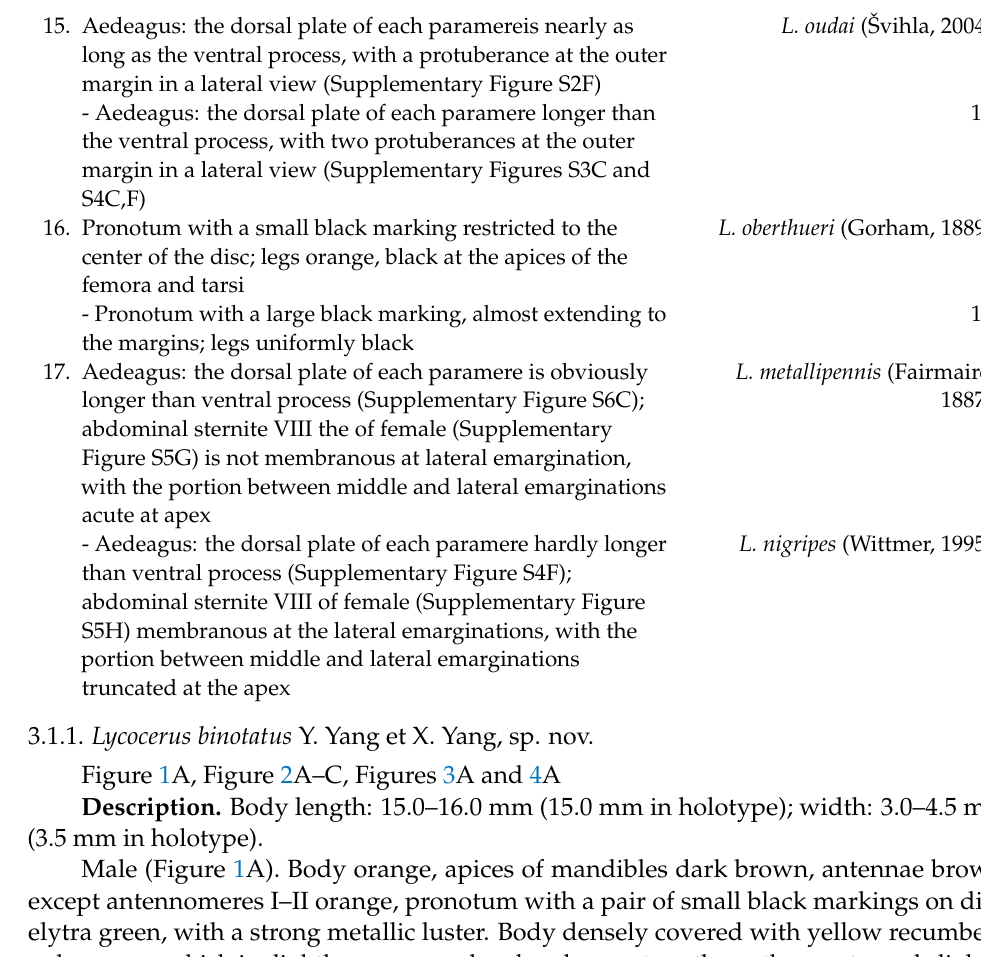
abdominal sternite VIII of female (Supplementary Figure S5H) membranous at the lateral emarginations, with the portion between middle and lateral emarginations truncated at the apex